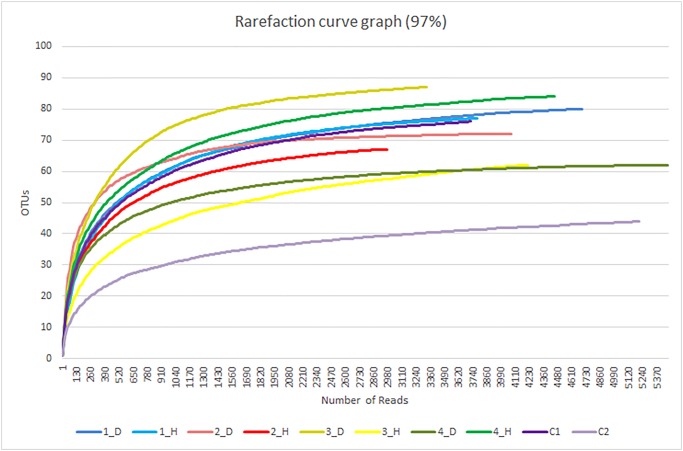
Rarefaction curve for 10 oral microbiome samples.Curves were plotted at a cutoff of 0.03 for each sample.